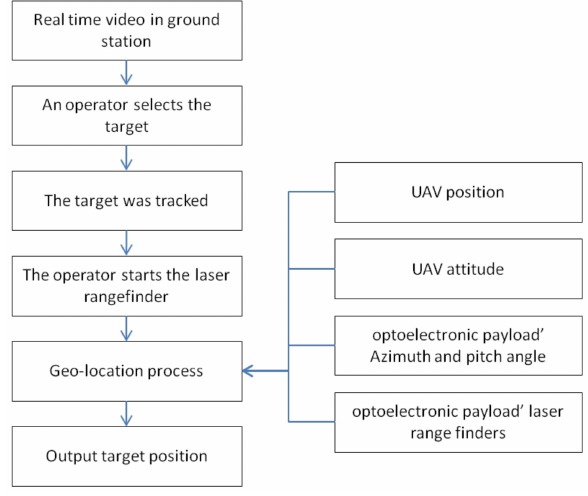
Figure 2. The geo-location process of system.